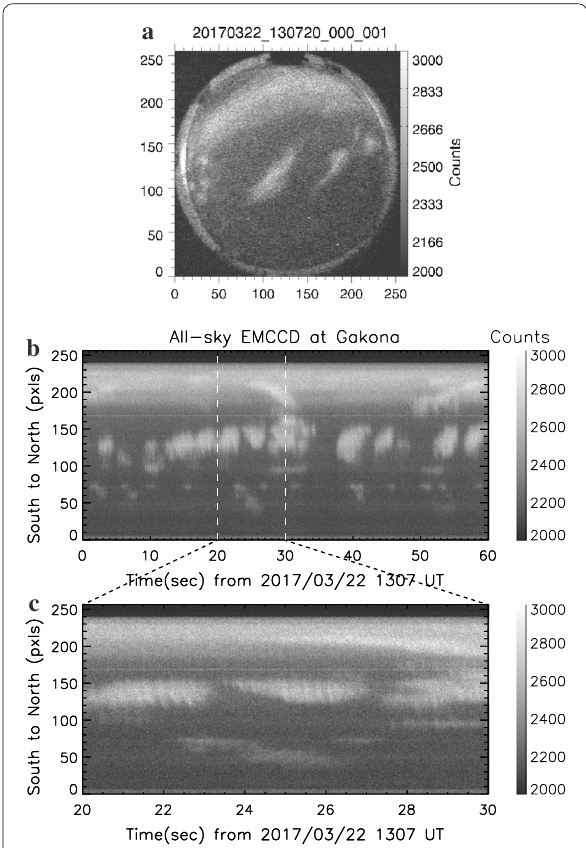
Fig. 16 Image ( a ) and north–south keograms ( b , c ) of pulsating auroral patches observed by an EMCCD camera with an R665 filters at